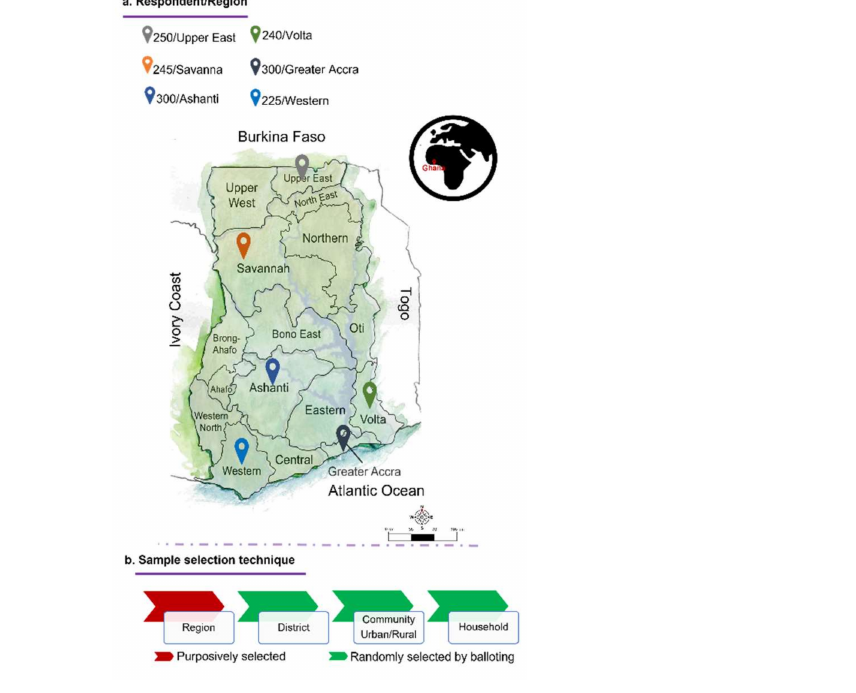
Figure 1. ( a ) Geographic locations of sampling within Ghana on the right and, ( b ) a scheme of sampling technique (sketch provided by Leja